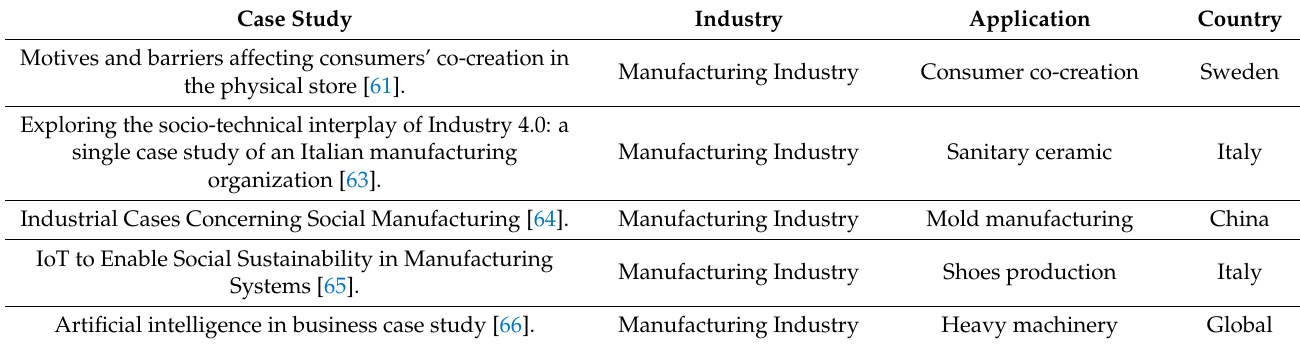
Table 3. Summary and information of case study: social